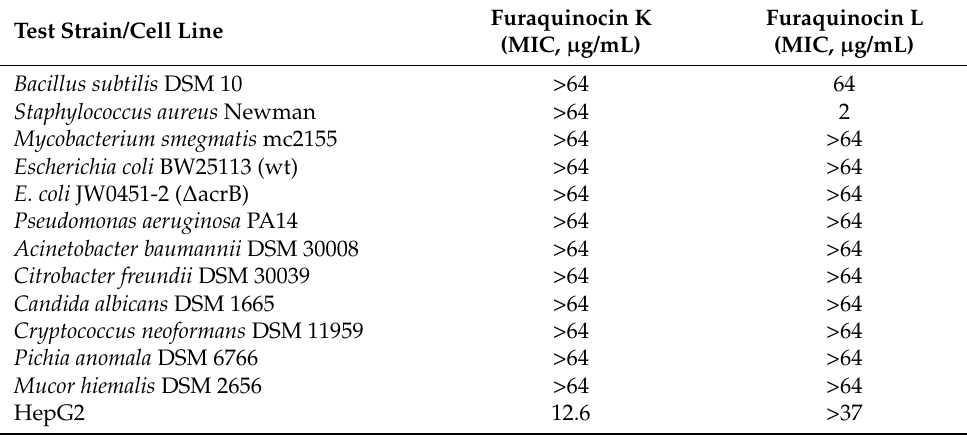
Table 4. Antibacterial and cytotoxic activities of furaquinocins K and L. Test Strain/Cell